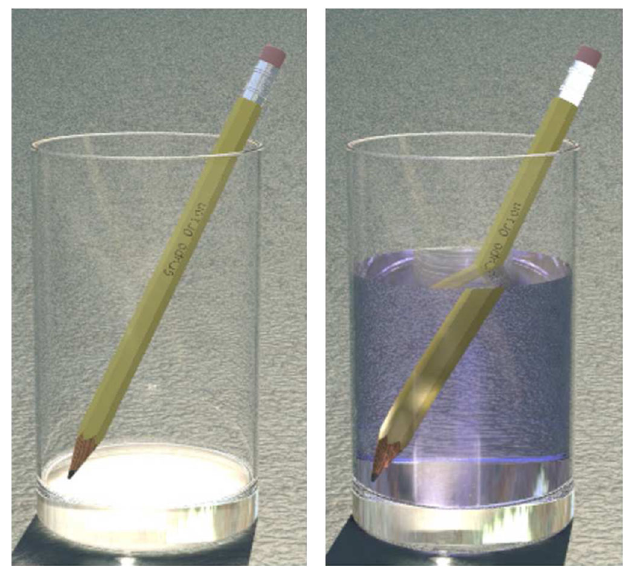
FIG. 1 (color online). Hyper-realistic simulation of a pencil in an empty glass (left). Hyper-realistic simulation of a pencil partially submerged in water ( n ¼ 1 : 33 ) seen from the air ( n ¼ 1 )